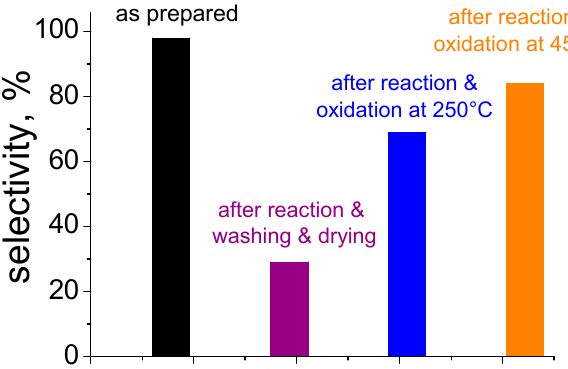
Figure 7. Comparison among the selectivity of the as prepared sample and after different reactivation procedures.